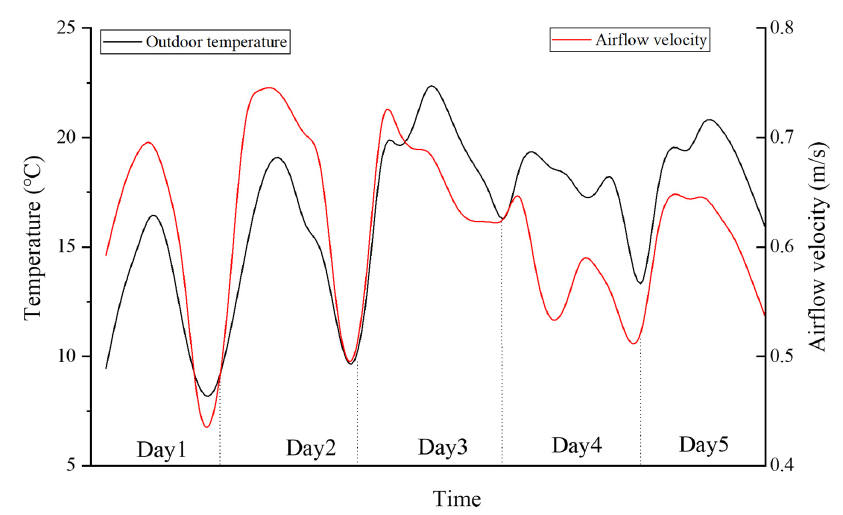
Figure 16. Change of airflow velocity and outdoor temperature at P1.